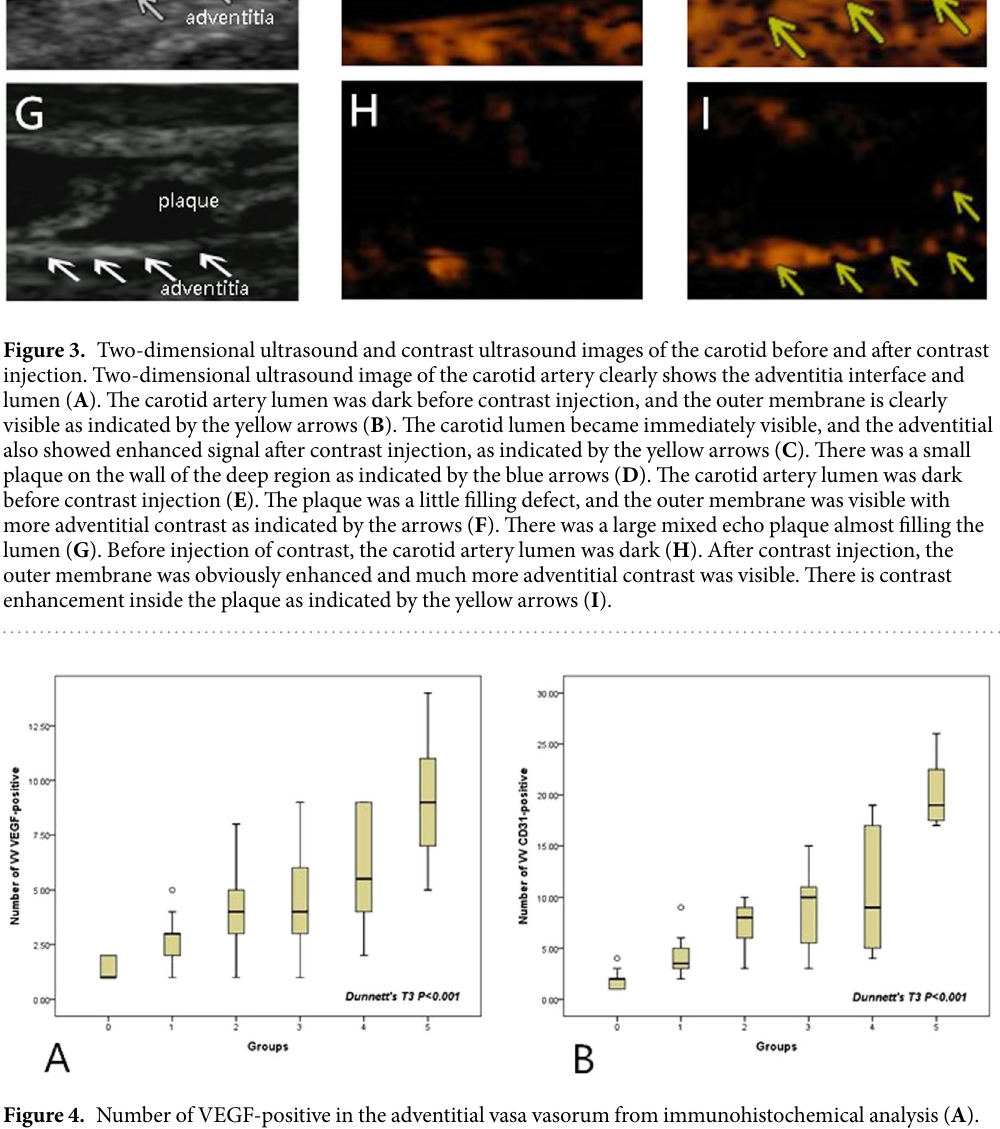
Figure 4. Number of VEGF-positive in the adventitial vasa vasorum from immunohistochemical analysis ( A ). Number of CD31-positive microvessels in the adventitial vasa vasorum from immunohistochemical analysis ( B